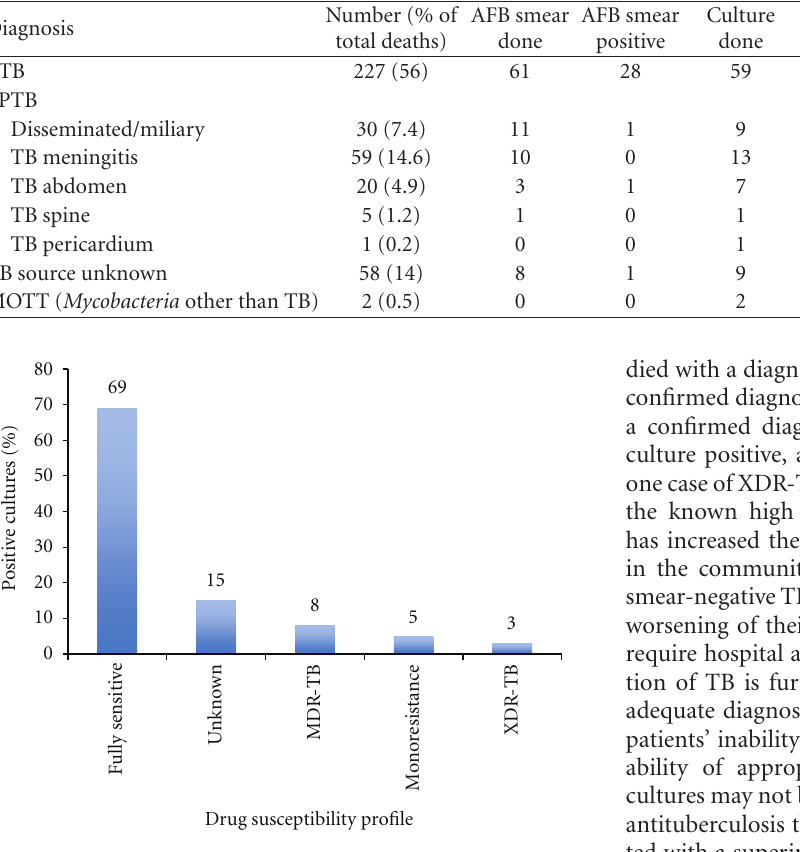
Figure 1: Drug susceptibility profile of positive